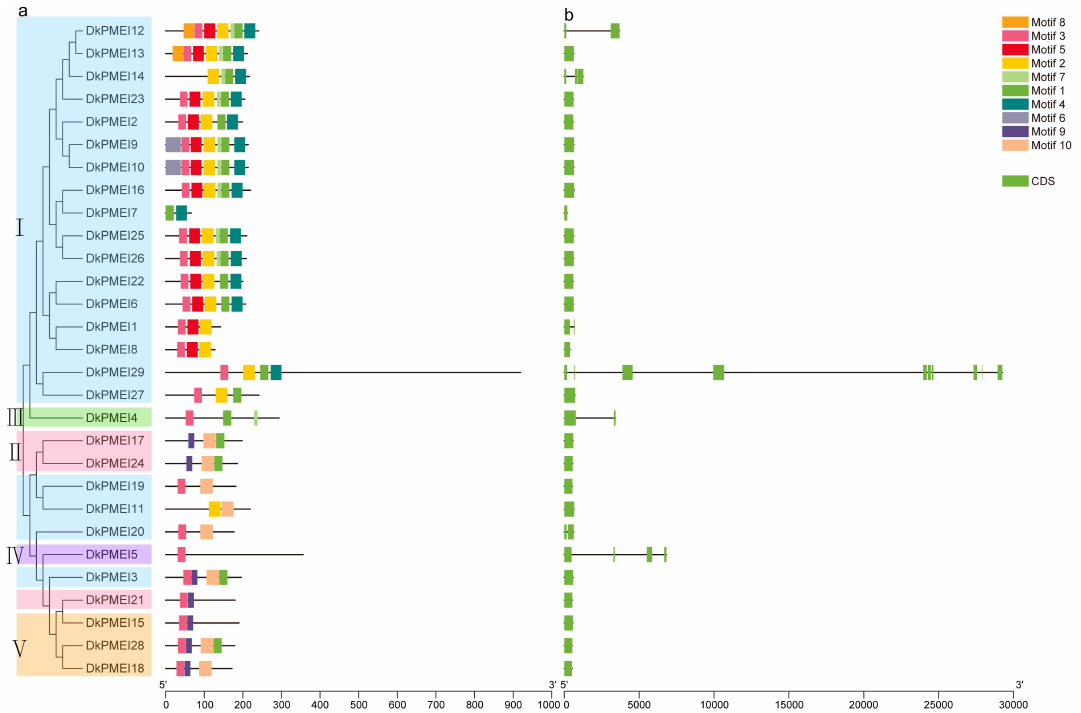
Figure 3. Conserved motif and gene structure analyses of PMEI genes in D. kaki . ( a ) Conserved motif distribution. ( b ) Exon–intron structure of DkPMEI